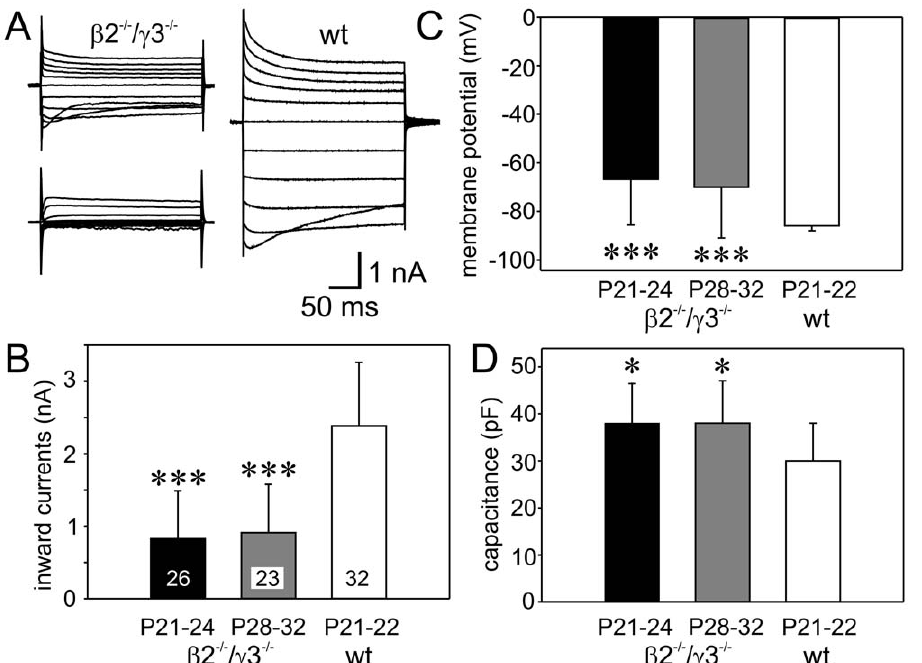
Figure 4. Electrophysiological properties of isolated Mu¨ller cells of mice at the age of 3–4 weeks. A: Depolarizing and hyperpolarizing voltage steps were applied from a holding potential of 2 80 mV with 20 mV increment. Whereas the current pattern of cells from wild-type mice (wt, right) was very similar to that shown before for adult mice, the currents recorded in cells from b 2 2 / 2 / c 3 2 / 2 mice had much smaller amplitudes (left). Moreover, the current patterns from b 2 2 / 2 / c 3 2 / 2 mice displayed a variability and inward currents were almost missing in some cells. Recordings were from a P21 (left, above), a P32 (left, below), and a P22 mouse (right) in b 2 2 / 2 / c 3 2 / 2 and wild-type animals, respectively. B–D: Significant alterations were observed in the inward currents at 60 mV hyperpolarization, the membrane potential and the membrane capacitance. Mean values with standard deviations are shown, numbers of recorded cells are given within the columns in B. Significant differences as compared to the wild- type control: *P , 0.05, ***P ,